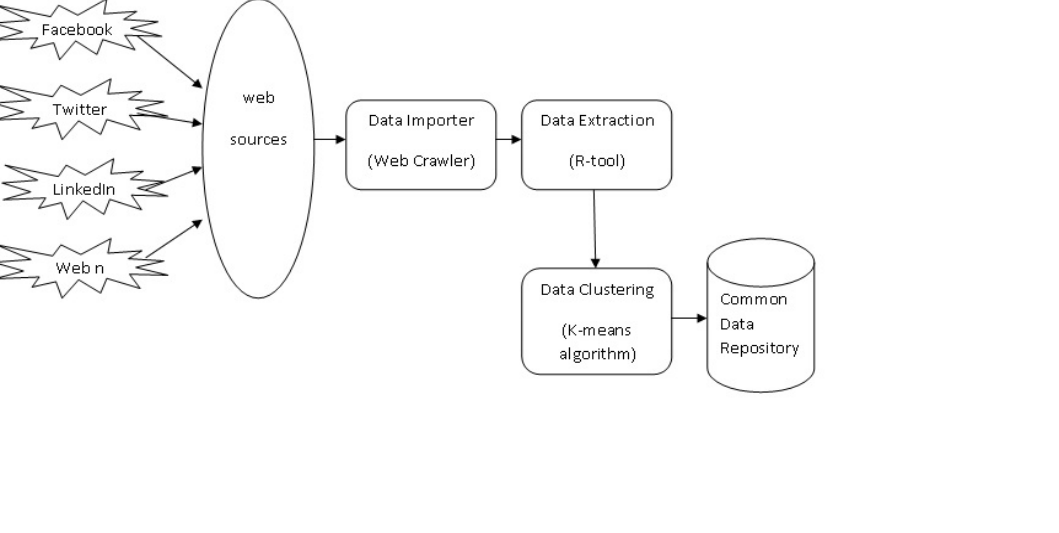
Figure 2 . Block diagram for data repository